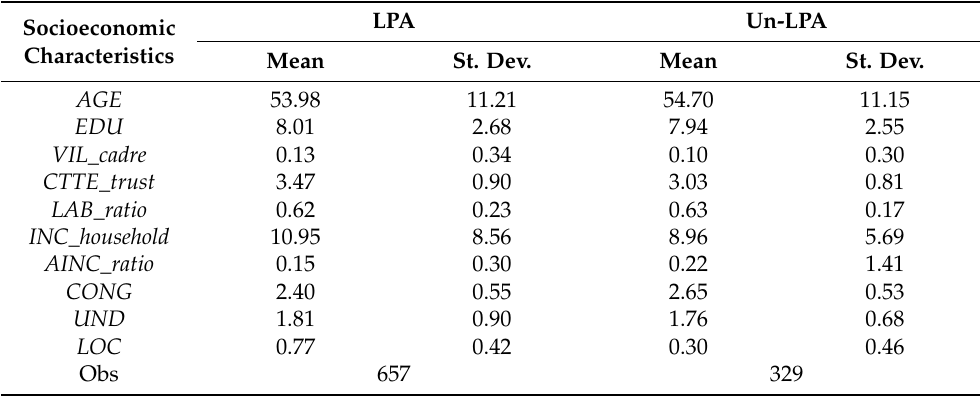
Table 5. Socioeconomic characteristics of the interviewed